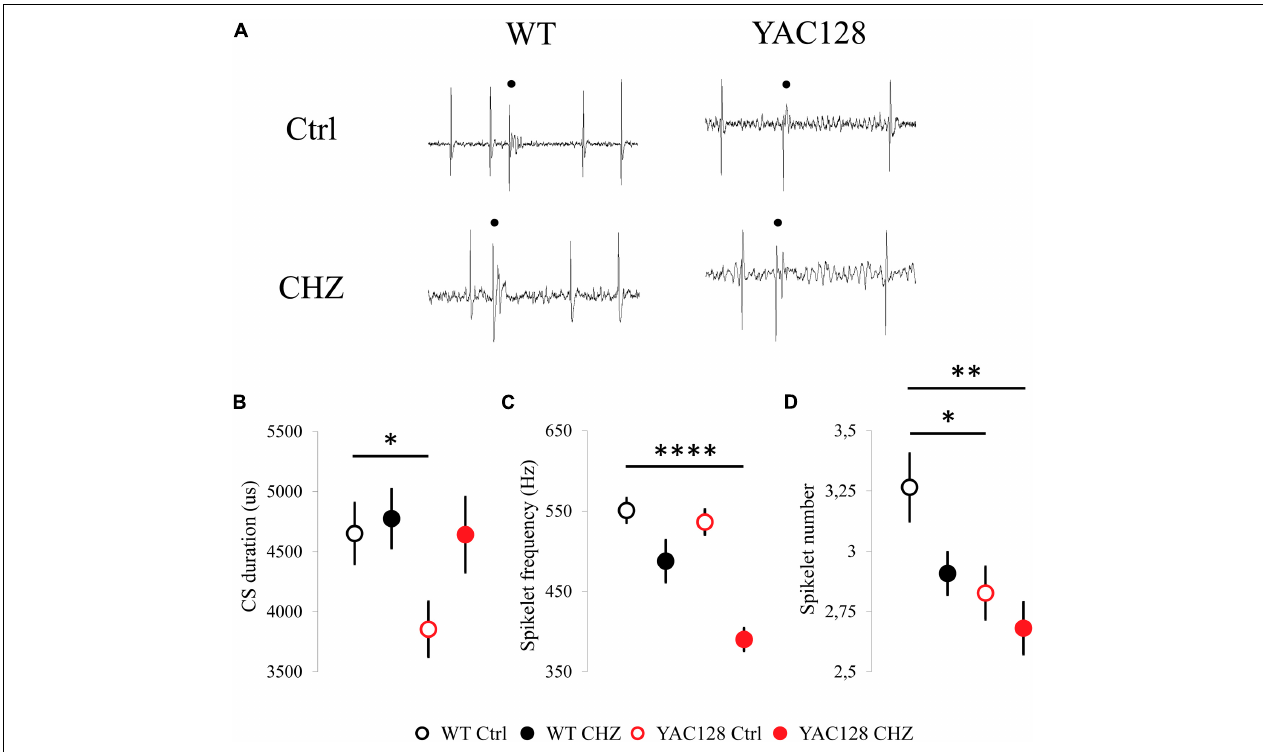
FIGURE 3 | Changes in CS shape induced by long-term CHZ injections in 12-month-old WT and YAC128 HD mice. (A) Examples of complex spikes generated by cerebellar PCs from 12-month-old WT and YAC128 mice in control groups and after long-term CHZ injections. Complex spikes are marked by filled circles. (B) The average CS duration was significantly less in 12-month-old YAC128 mice compared to WT mice and was recovered after treatment with CHZ. * p < 0.05. (C) After CHZ treatment the significant decrease in spikelet frequency of the CS from YAC128 PCs was observed. **** p < 0.0001. (D) The spikelet number of the CS from YAC128 PCs was significantly less in both YAC128 control and CHZ groups compared to WT PCs. * p < 0.05, ** p < 0.01. The number of the analyzed tonic cells (n) and number of animals (m) were indicated in Figure 2